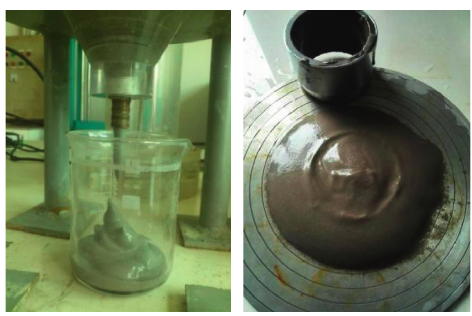
Figure 6: Underflow of dynamic thickening test.